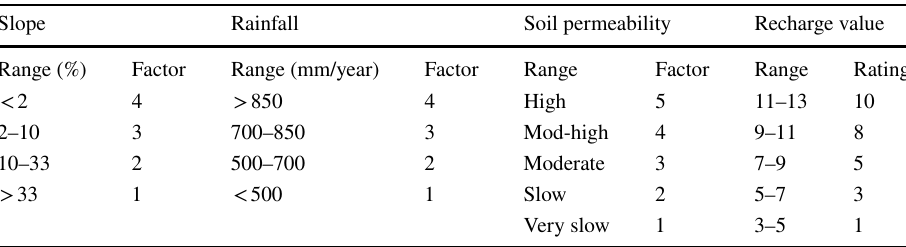
according to Piscopo method